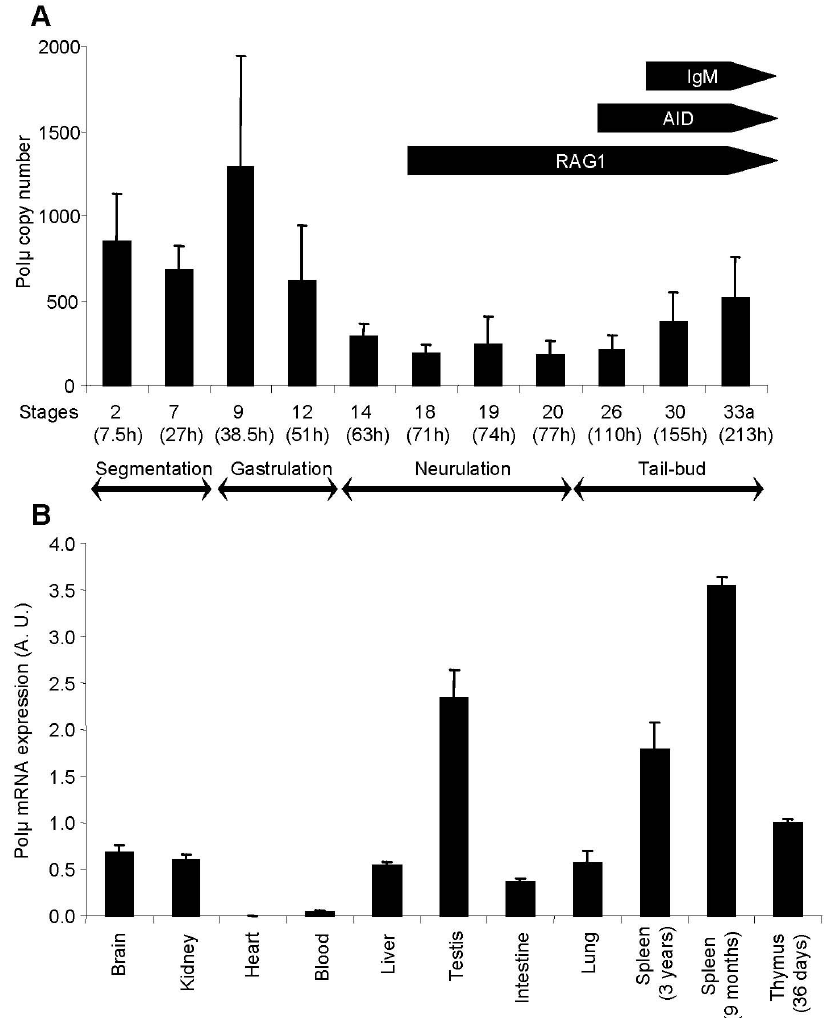
Figure 2. P. waltl polymerase m mRNA expression profiles. Pol m transcripts were quantified by real-time PCR during early stages of development ( A ) and in various tissues ( B ). Arrows indicate the expression of AID, IgM heavy chains and RAG1 transcripts, as reported in previous studies [4,6]. Developmental stages, as well as the time elapsed since laying (between brackets), are indicated. Ten embryos were studied for each developmental stage. The relative value obtained for the thymus of stage 44 larvae was set to 1 as a reference for tissue expression. Values represent means 6 SEM.